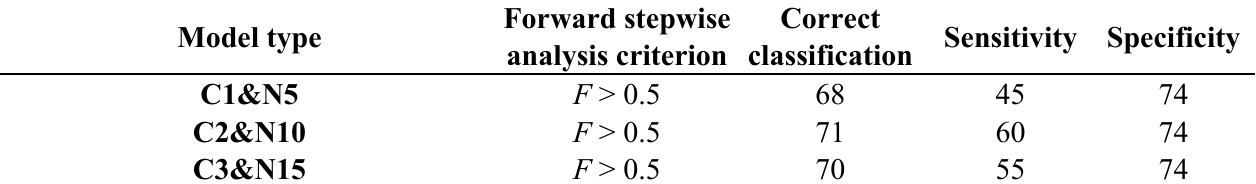
Table 6. External validation statistics (%) of the CYP2D6